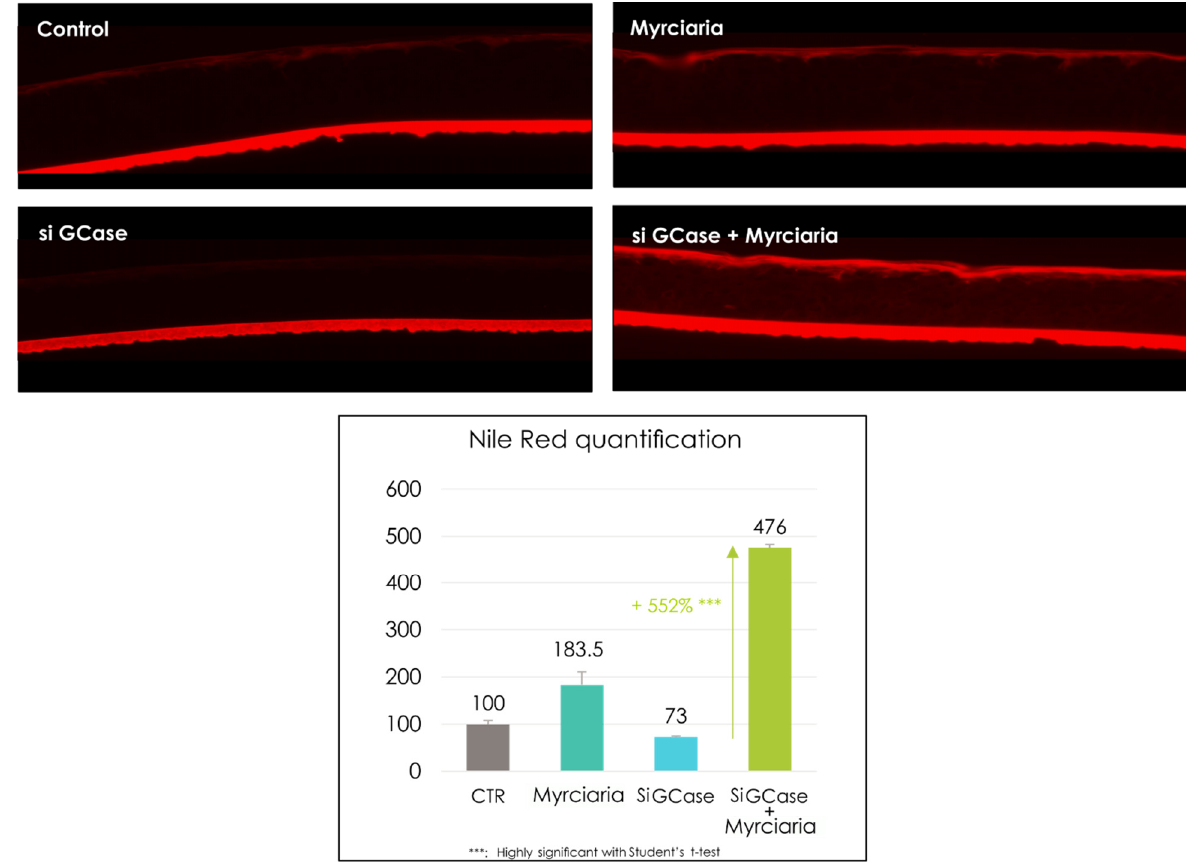
Figure 4. Effect of Myrciaria dubia fruit extract on lipid synthesis in GCase-deficient RHE. Keratinocytes were silenced with siGBA before the reconstruction. At day 6, RHE were treated with Myrciaria Dubia fruit extract for 2 days. Nile red staining was performed on RHE at day 8 (three pictures per condition were analyzed).